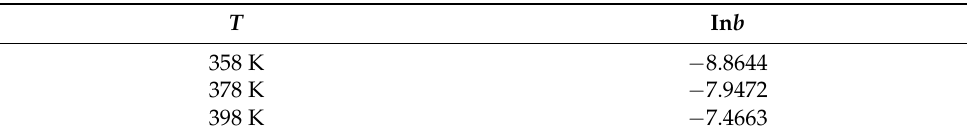
Table 10. Data table of parameter b and temperature T at three temperature points.